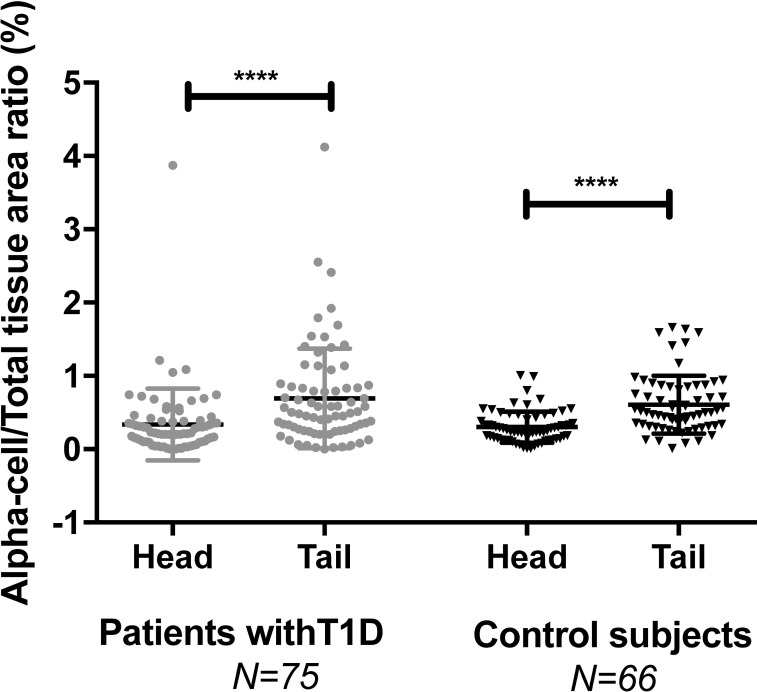
α-cell to total tissue area ratio in the head and tail of the pancreas of patients with T1D and control subjects.Data representation is the same as in Fig 5.